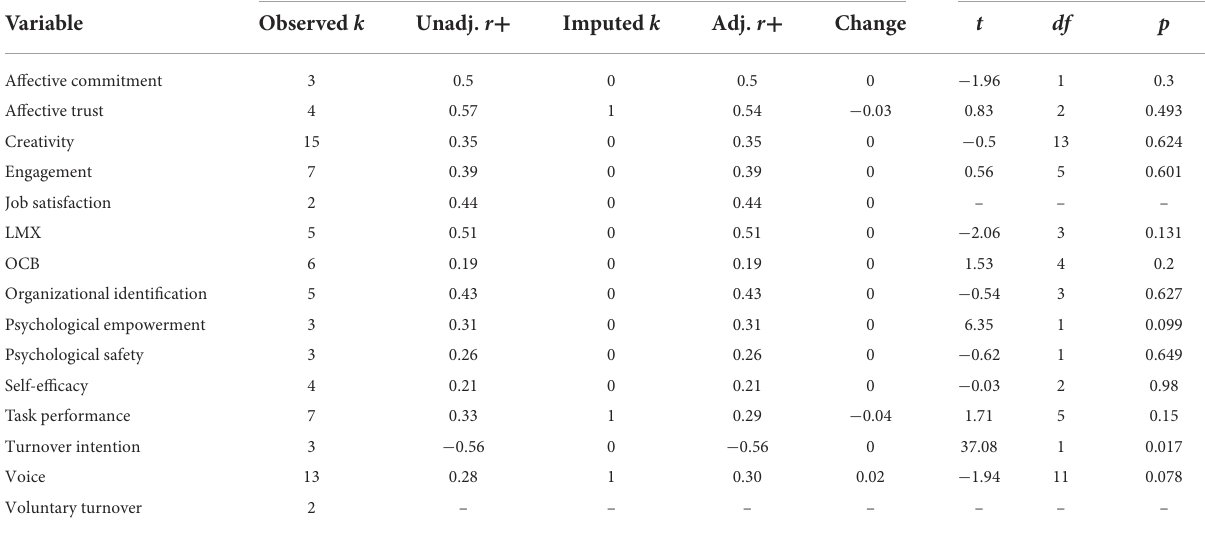
TABLE 2 Publication bias analysis.